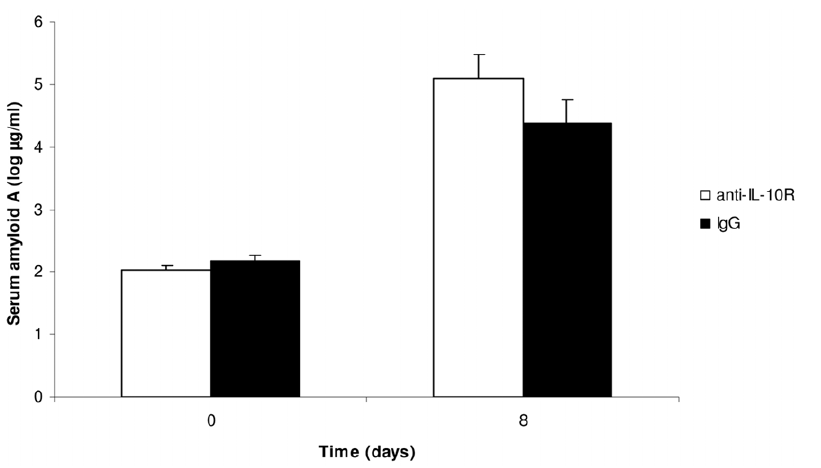
Figure 5. Effect of the LPS treatment on the production of plasmatic serum amyloid A. The bars represent the mean 6 SE.